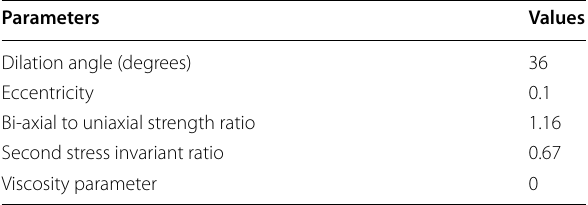
Table 3 Parameters of concrete damage plasticity.